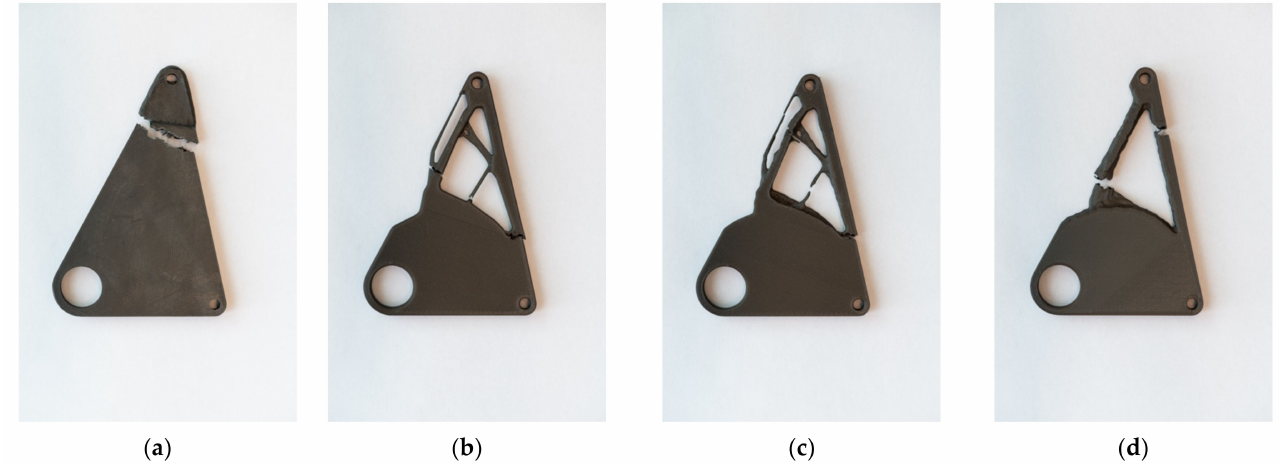
Figure 15. Printed and tested specimens: ( a ) reference; ( b ) redesigned; ( c ) smoothed; and ( d ) MaSmo. The force–displacement plots are illustrated in Figure 16. The measured data’s qualita- tive mean curves are obtained by using a Gaussian process regression (gpr) model trained with the experimental data. Therefore, a radial basis function kernel with an added white kernel to handle the noise is used